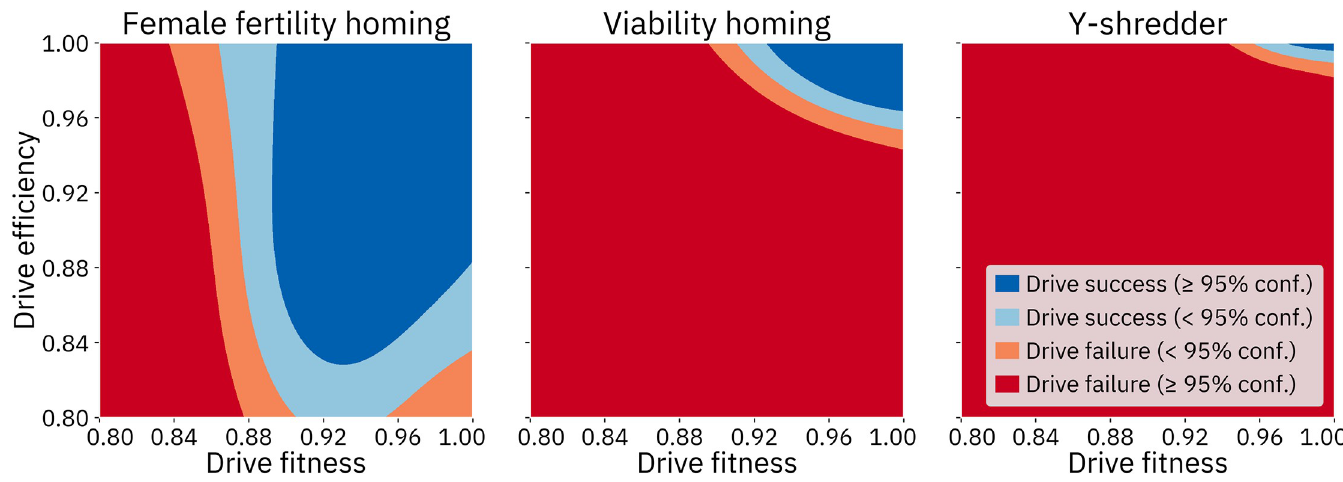
Fig 10. Comparison of the three drives with varying fitness and efficiency. Other parameters were fixed at default values. For each panel, a 1000 by 1000 array of queries was made to the GP model for that drive.